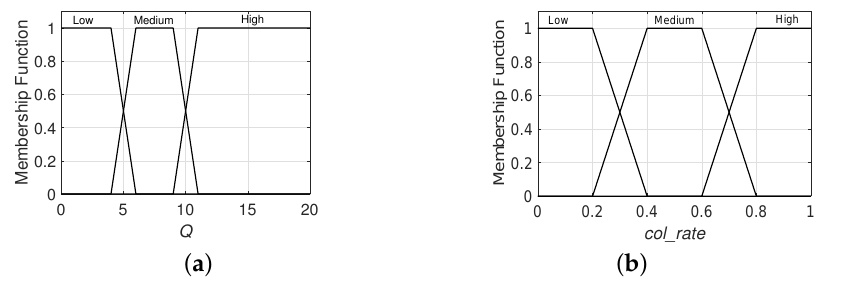
Figure 3. Membership functions: ( a ) for Q , ( b ) col _ rate .